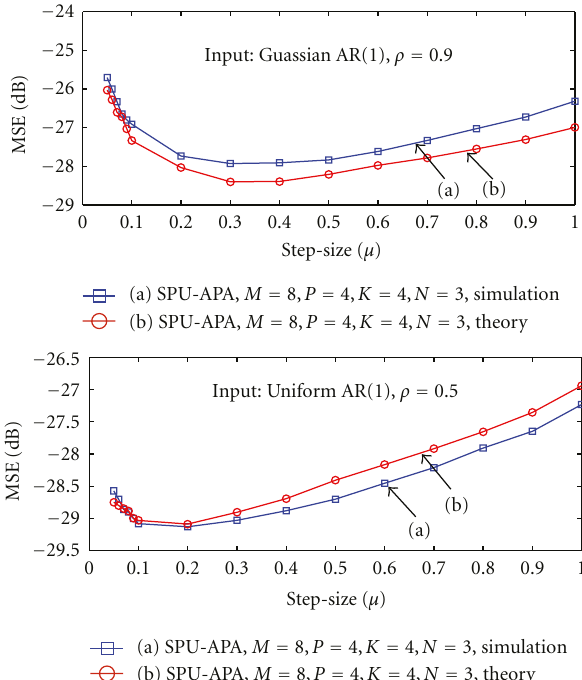
Figure 8: Steady-state MSE of SPU-NLMS with M = 8, K = 4 and N = 4 as a function of the step size in nonstationary environment for di ff erent input signals.